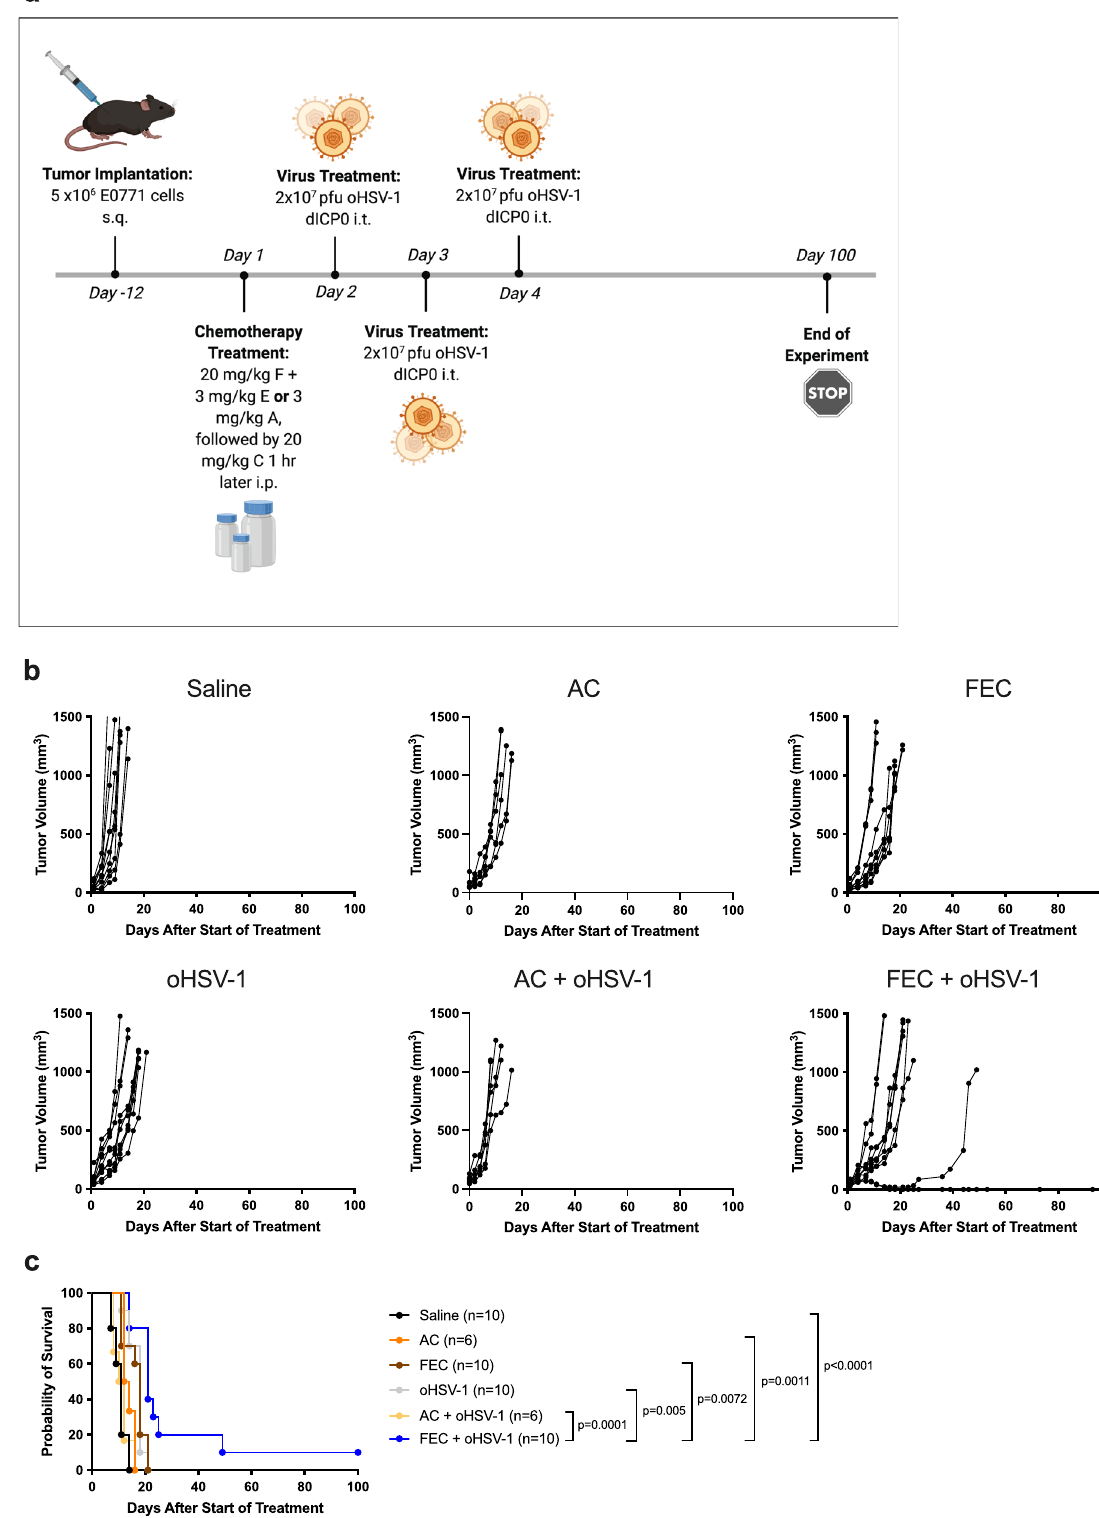
Fig. 1 FEC + oHSV-1 slows tumor growth and decreases tumor kinetics and results in tumor regression in 10% of mice. a C57/Bl6 mice bearing E0771 tumors were treated with saline, chemotherapy (FEC or AC), oncolytic virus (oHSV-1 dICP0), or chemotherapy + oncolytic virus. *Created using BioRender.com. b Tumor volumes were measured every 2 – 3 days from the start of treatment until mice reached endpoint. Each line represents an individual mouse within the group. c Kaplan – Meier survival curves of each group. *Mantel – Cox test was used for statistical analyses.